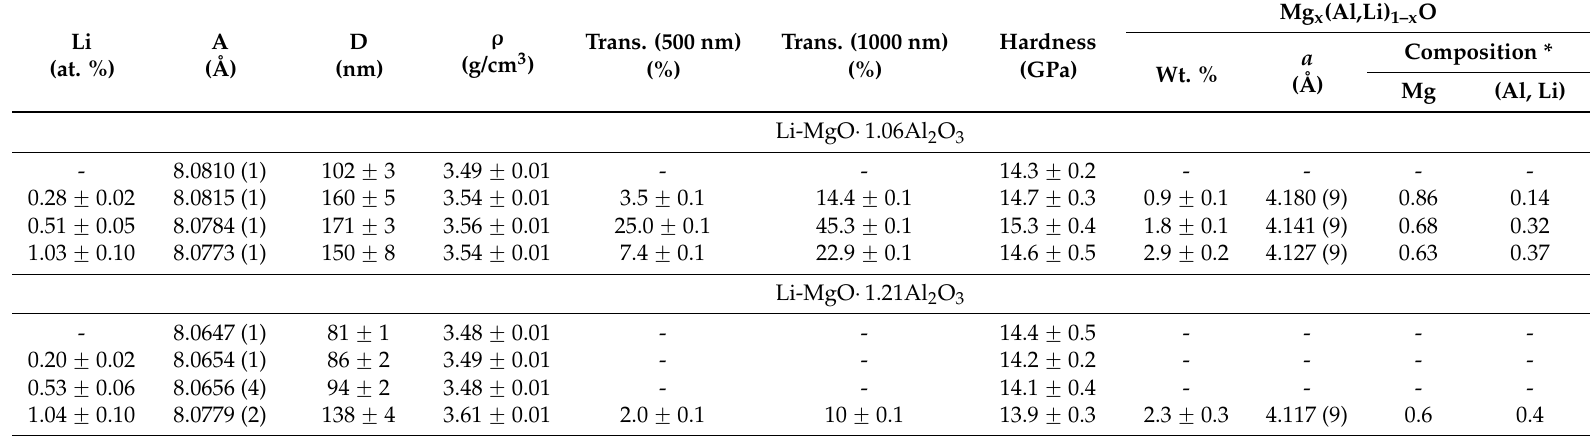
* Calculated using the Vegard rule and data from Doman’s work